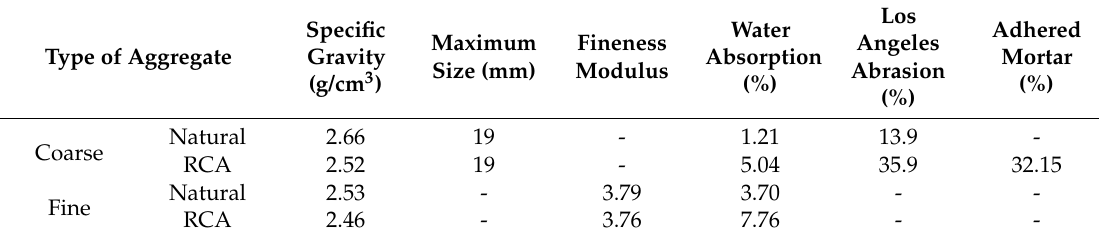
Table 1. Physical properties of NA and RCA.